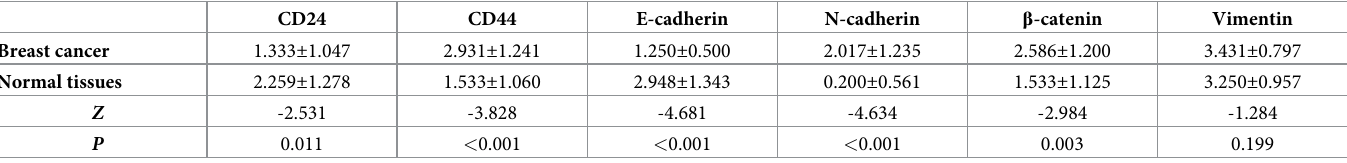
Table 1. Immunohistochemical score of CSCs and EMT in breast cancer tissues (n = 56). CD24 CD44 E-cadherin N-cadherin β -catenin Vimentin Breast cancer 1.333 ± 1.047 Normal tissues P